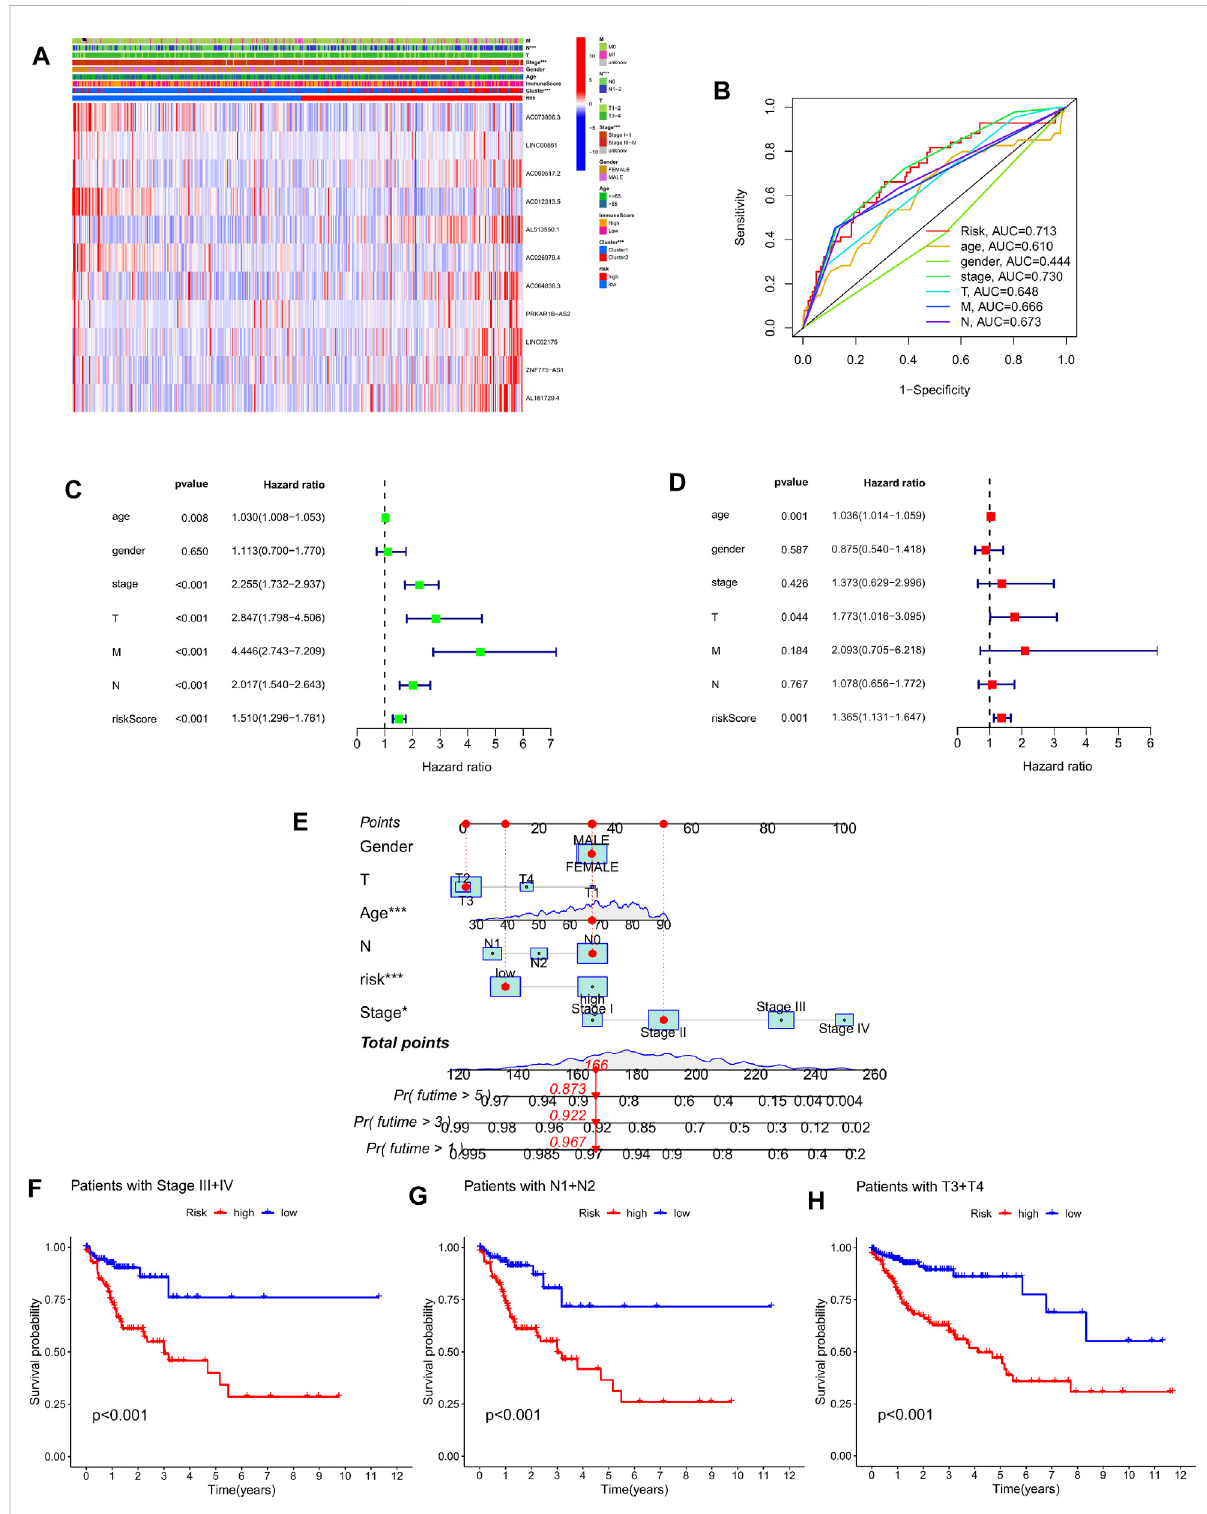
FIGURE 6 Prognostic clinical value and nomogram plotting of the risk model. (A) Heat map showing signi fi cant differences in pN stage, clinical stage, and clustering between high-risk and low-risk groups. (B) Multivariate ROC curves and AUC values combined with clinicopathological features. (C – D) Forest plotsofunivariateandmultivariate Coxregressionanalysis ofvariables associated withOS. (E) Nomogram forpredicting1-,3-,and 5-yearOS in colon cancer patients. (F – H) Survival curves of high- and low-risk groups in StageIII + IV, N1+N2, and T3+T4